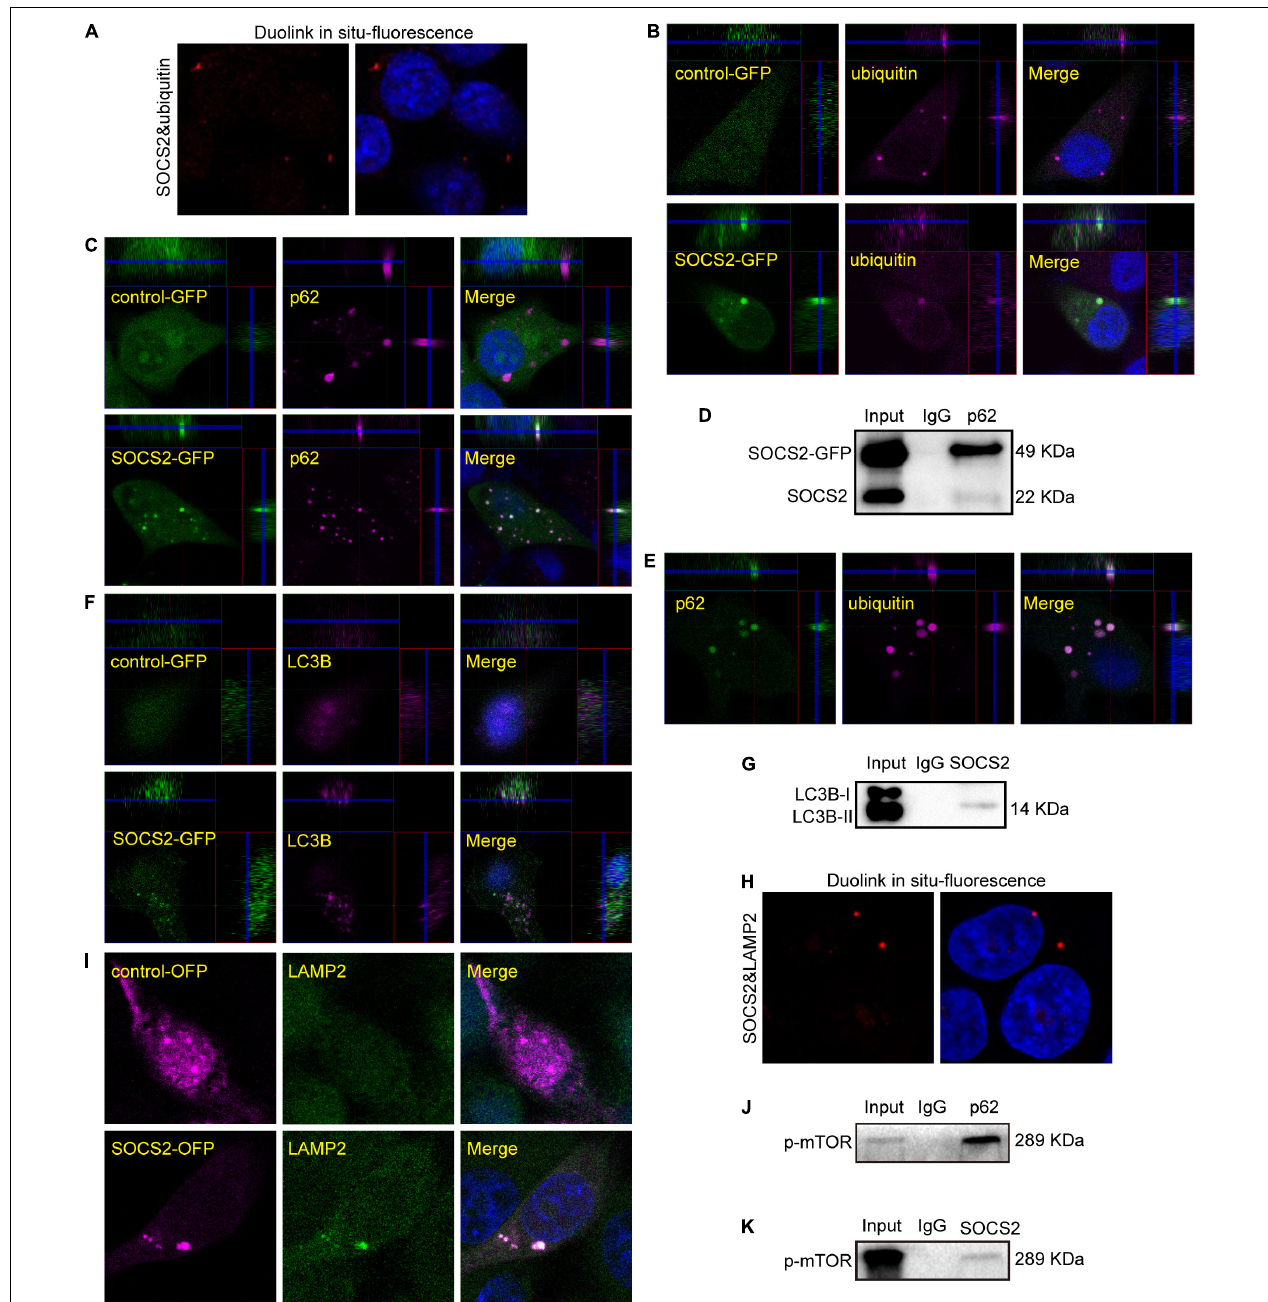
FIGURE 4 | Ubiquitylated proteins recognized by SOCS2 were transferred into autophagosomes and autolysosomes. (A) The endogenous detection of protein interaction between SOCS2 and ubiquitin was detected in starved ARPE-19 by Duolink in situ fluorescence. The red fluorescence indicated the interaction of SOCS2 and ubiquitin. (B) Immunofluorescence staining with ubiquitin (red) and DAPI (blue) was performed in starved ARPE-19 with transient transfection of GFP control vectors or SOCS2-GFP plasmids. The yellow dots indicated the colocalization of SOCS2 and ubiquitin in merged pictures. (C) Immunofluorescence staining with the antibody p62 (red) and DAPI (blue) in ARPE-19 with the same treatment of B. The yellow dots indicated the colocalization of SOCS2 and p62 in merged pictures. (D) The immunoprecipitation of p62 and SOCS2 was detected in ARPE-19 with the same treatment of B. (E) Immunofluorescence staining was performed with the antibodies against p62 (green) and ubiquitin (red) in starved ARPE-19. (F) Immunofluorescence staining with the antibody LC3B (red) in ARPE-19 with the same treatment of B. (G) The immunoprecipitation of LC3B and SOCS2 was detected in ARPE-19 with the same treatment of B. (H) The endogenous detection of protein interaction between SOCS2 and LAMP2 was detected in starved ARPE-19 by Duolink in situ fluorescence. The red fluorescence indicated the interaction of SOCS2 and LAMP2. (I) Immunofluorescence staining with the antibody LAMP2 in ARPE-19 after transient transfection of SOCS2-OFP plasmids or OFP control vectors. (J,K) The immunoprecipitation of p62 and phosphorylated mammalian target of rapamycin (p-mTOR), SOCS2, and p-mTOR were detected in ARPE-19 with the same treatment of B.